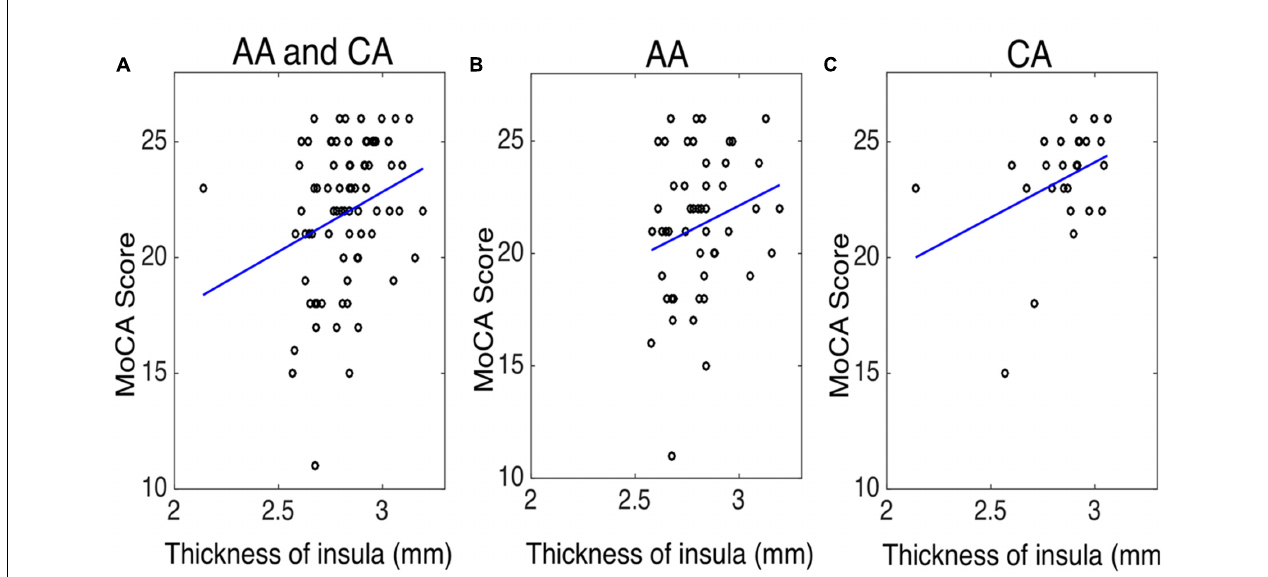
FIGURE 5 | The correlation between the thickness of insula and the Montreal cognitive assessment (MoCA) score in (A) both African–Americans (AA) and Caucasian–Americans (CA) ( r = 0.30 and p < 0.05), (B) AA ( r = 0.19 and p = 0.18), and (C) CA ( r = 0.40 and p < 0.05).